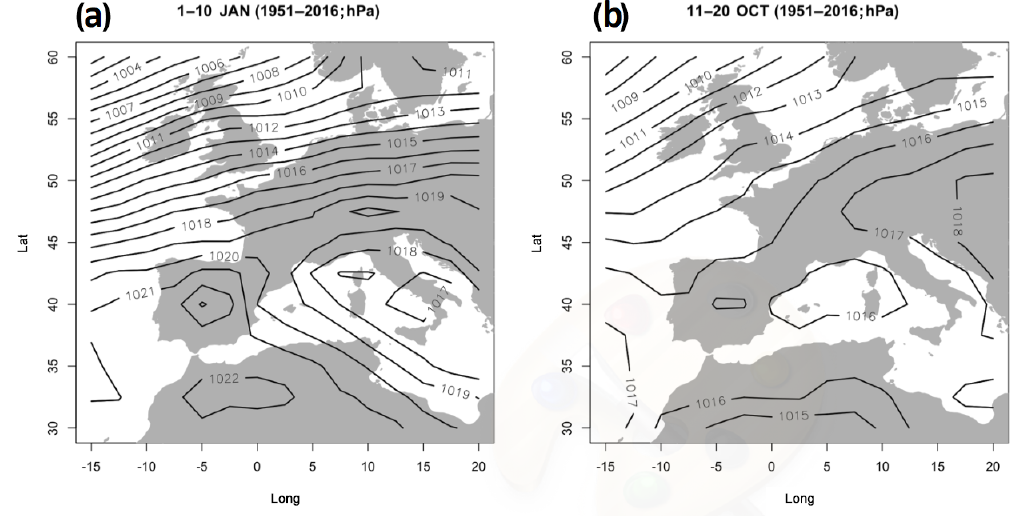
Figure 8. Sea level pressure (SLP) mean of the synoptic window 30–60 ◦ N and 15 ◦ W–20 ◦ E from 1 to 10 January (a) and from 11 to 20 October (b) during the 1951–2016 study period. Data source: NCEP Reanalysis data provided by the NOAA/OAR/ESRL PSD, Boulder, Colorado,